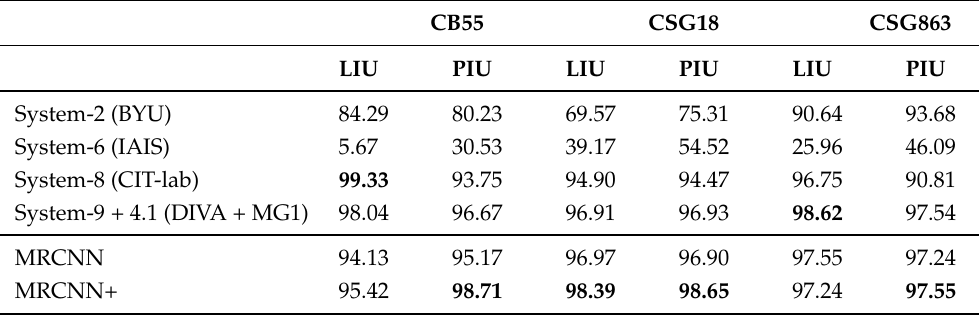
Table 1. The results of the ICDAR2017 competition on layout analysis for challenging medieval manuscripts ([27]). Line IU and Pixel IU results of Task 3 of all competition participants and the proposed method. LIU denotes Line IU, and PIU denotes Pixel